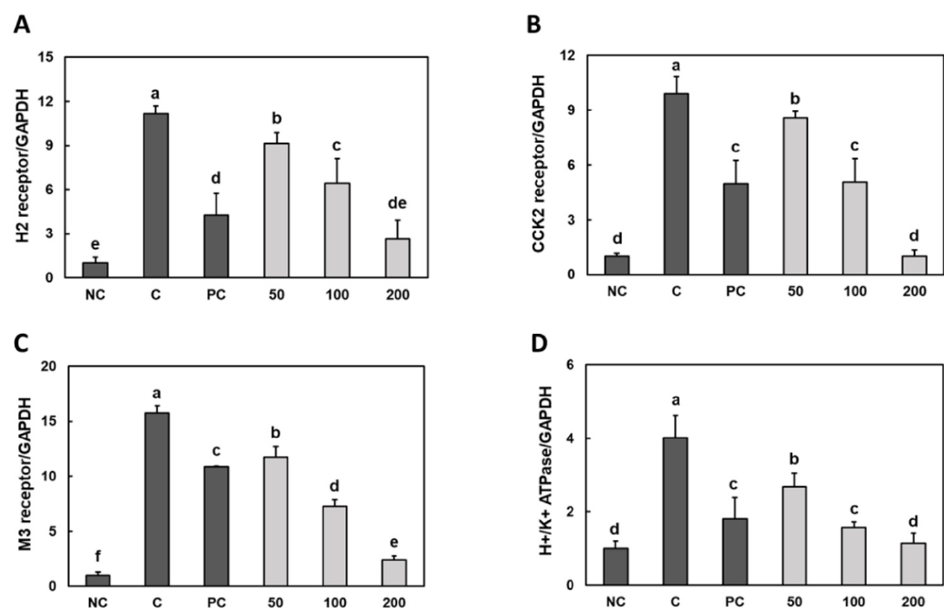
Figure 2. Effect of Gastro-AD ® on the expression of gastric acid secretion-related receptors in gastric damage induced by ethanol/HCl treatment in SD rats. The mRNAs levels of ( A ) histamine-induced histamine 2 receptor (H2r), ( B ) gastrin-induced cholecystokinin 2 receptor (CCK2r), ( C ) acetylcholine-induced muscarinic acetylcholine receptor M3 (M3r) and ( D ) H + /K + ATPase. Normal control (NC; − ethanol/HCl); ethanol/HCl control (C); ethanol/HCl with 30 mg/kg b.w. of rebamipide (positive control; PC); ethanol/HCl with 50 mg/kg b.w. of Gastro-AD ® (50); ethanol/HCl with 100 mg/kg b.w. of Gastro-AD ® (100); and ethanol/HCl with 200 mg/kg b.w. of Gastro-AD ® (200). Values are presented as mean ± SD ( n = 8). Different letters indicate a significant difference, with p < 0.05, as determined using Duncan’s multiple range test.